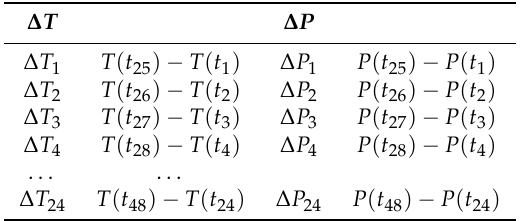
Figure 4. Description of the main idea of the study. Table 1. Calculating ∆ T and ∆ P